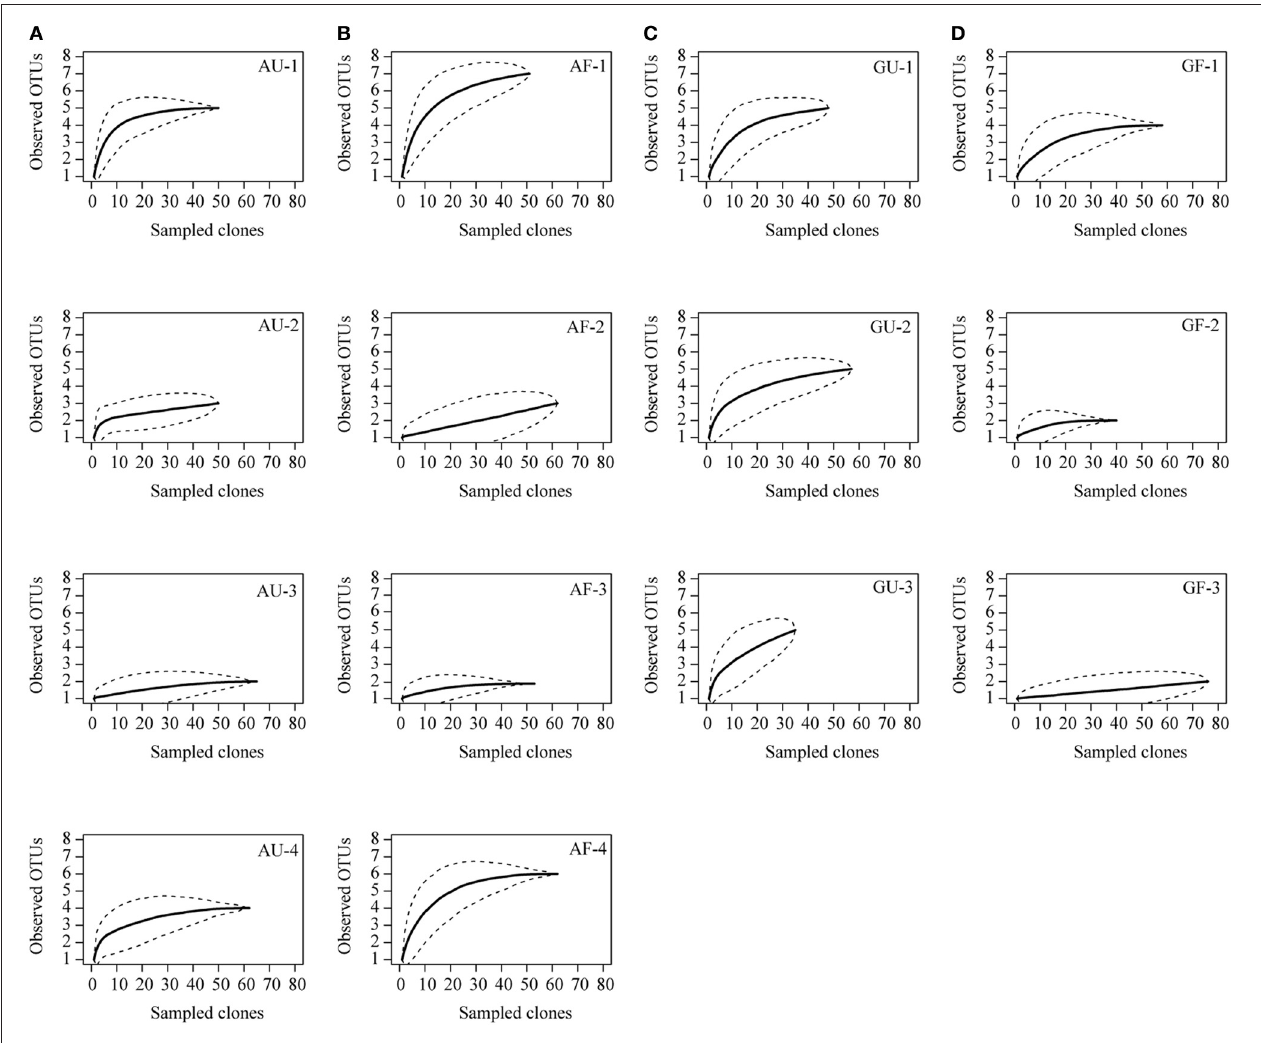
FIGURE A1 | Rarefaction curves of archaeal amoA genes retrieved from ambient temperature and unfertilized soils (A), ambient temperature fertilized soils (B), geothermally heated unfertilized soils (C) and geothermally heated fertilized soils (D). Shown are estimated numbers of OTUs(solid line) as well as the lower and